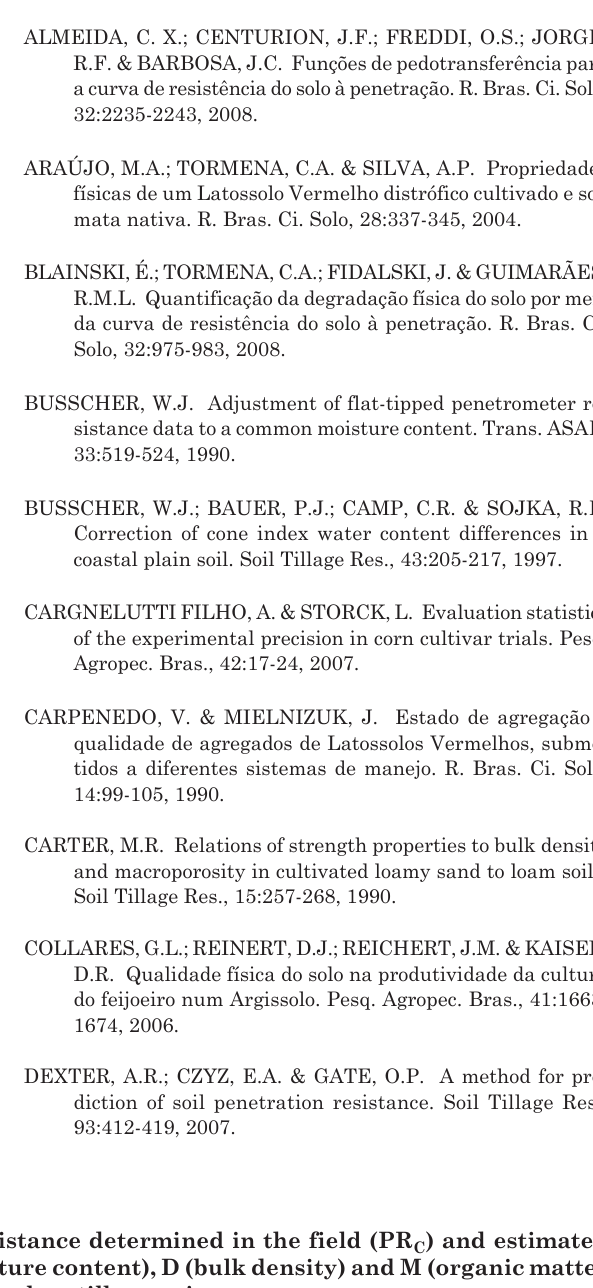
table 4. average value (n=960) for penetration resistance determined in the field (Pr c ) and estimated (Pr e ) based on the data for g (gravimetric moisture content), d (bulk density) and M (organic matter content) of a eutroferric red oxisol under annual no-till cropping